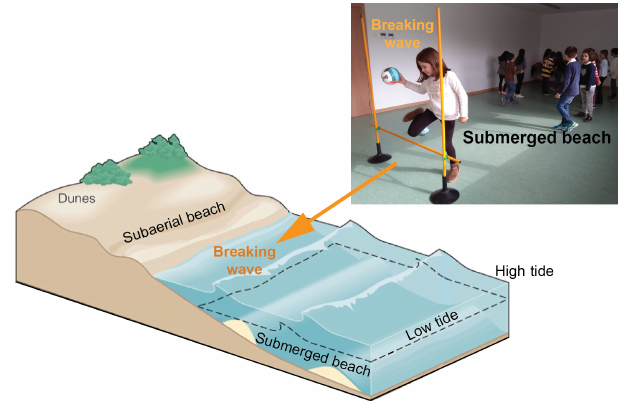
Figure 3. Coastal environments: dunes, subaerial beach, and sub- merged beach. The photograph shows a breaking wave, with a jump over the yellow horizontal bar representing the position that sepa- rates the subaerial from the submerged beach (towards the right- hand side, where children are in two rows of propagating